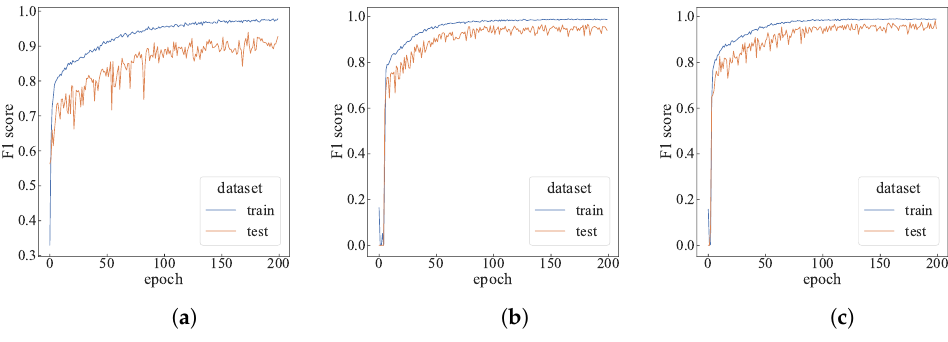
Figure 10. Performance comparison with different time steps. ( a ) T = 3; ( b ) T = 7; ( c ) T = 9.